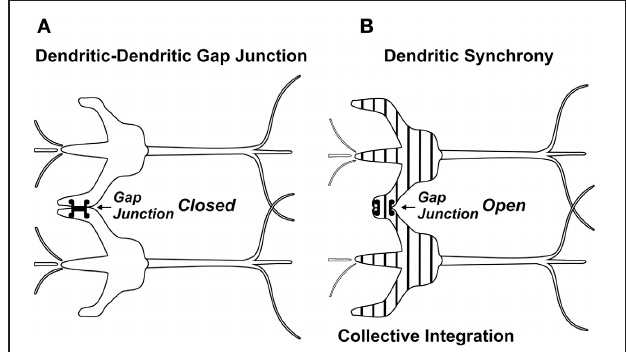
FIGURE 3 | (A) Dendrites of adjacent neurons linked by gap junction which remain closed. The gap junction connection is “sideways,” lateral to the flow of synaptic information. (B) Dendritic-dendritic gap junction open, synchronizing (vertical stripes) electrophysiology and enabling collective integration among gap junction-connected neurons.